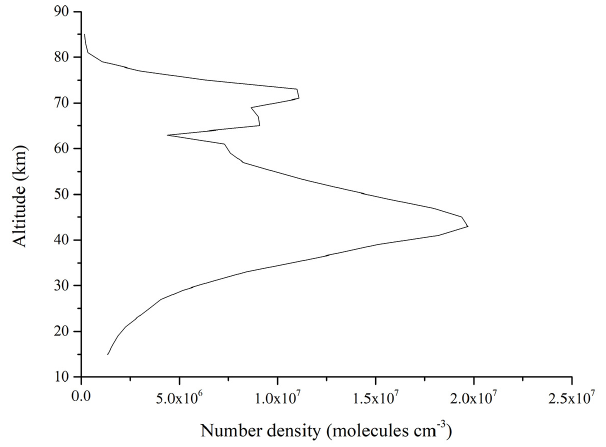
Figure 17. Inversion results in the target area using the tomographic retrieval